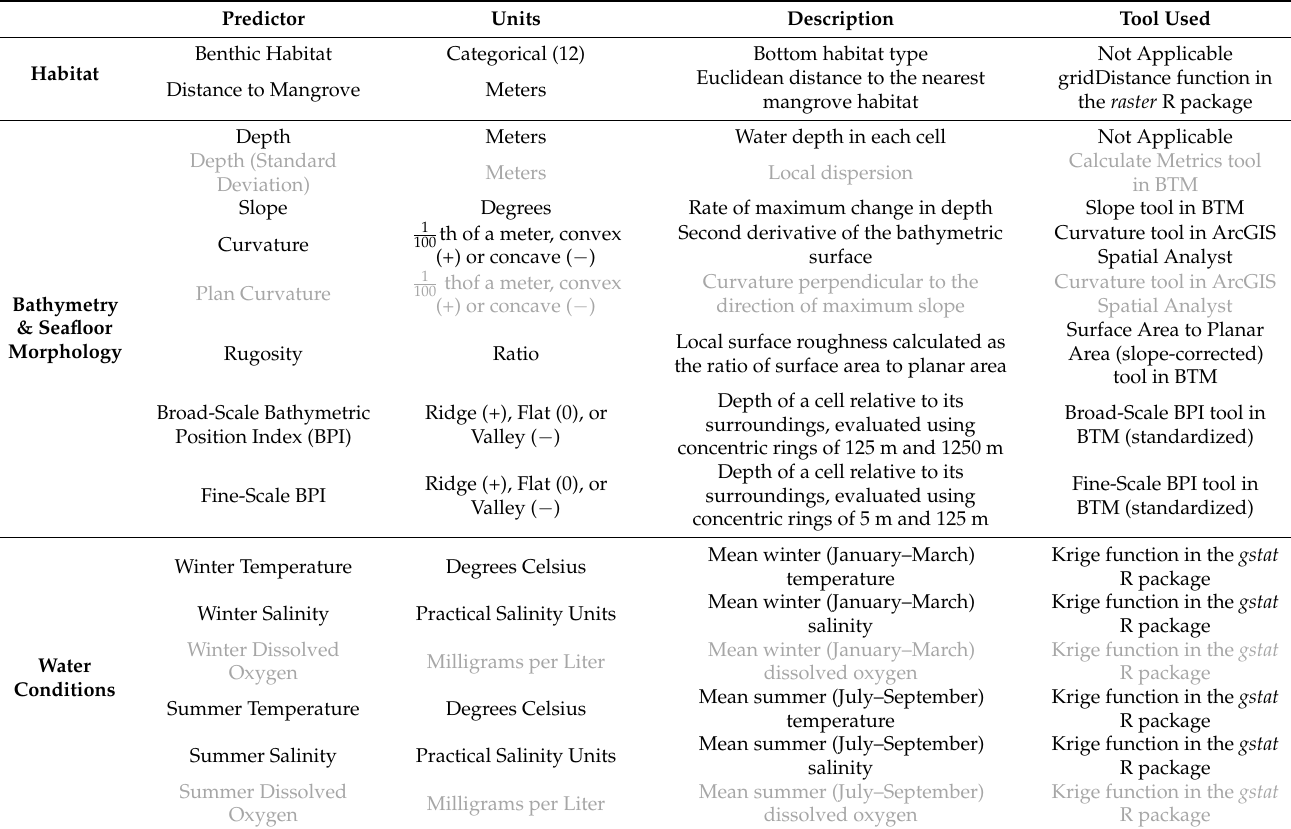
Table 1. Spatial predictors available for habitat suitability modeling. Grayed-out predictors were removed due to collinearity issues. BTM: Benthic Terrain Modeler ArcGIS extension (v3.0). Calculations performed using a 3 × 3 moving window of cells, unless otherwise